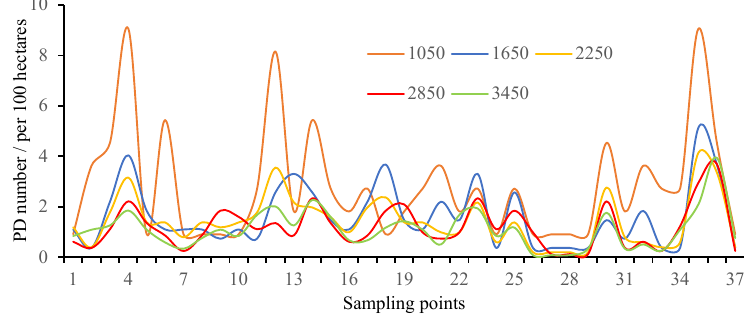
Figure 5. Changes in PD along the transect under different window sizes.